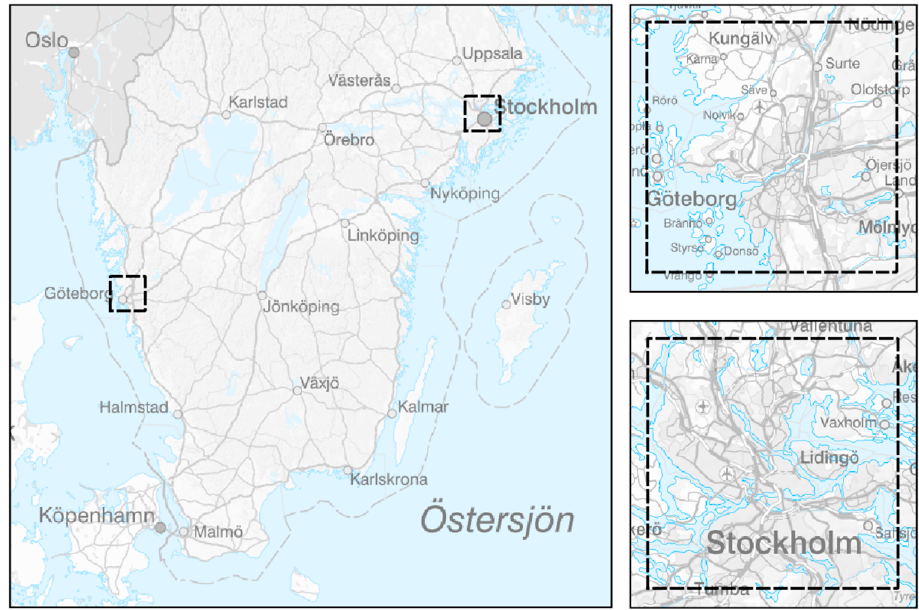
Figure 1. Modeling areas of 35 × 35 km 2 . An overview is displayed on the left; zoomed in maps are shown for Gothenburg (upper right) and Stockholm (lower right).